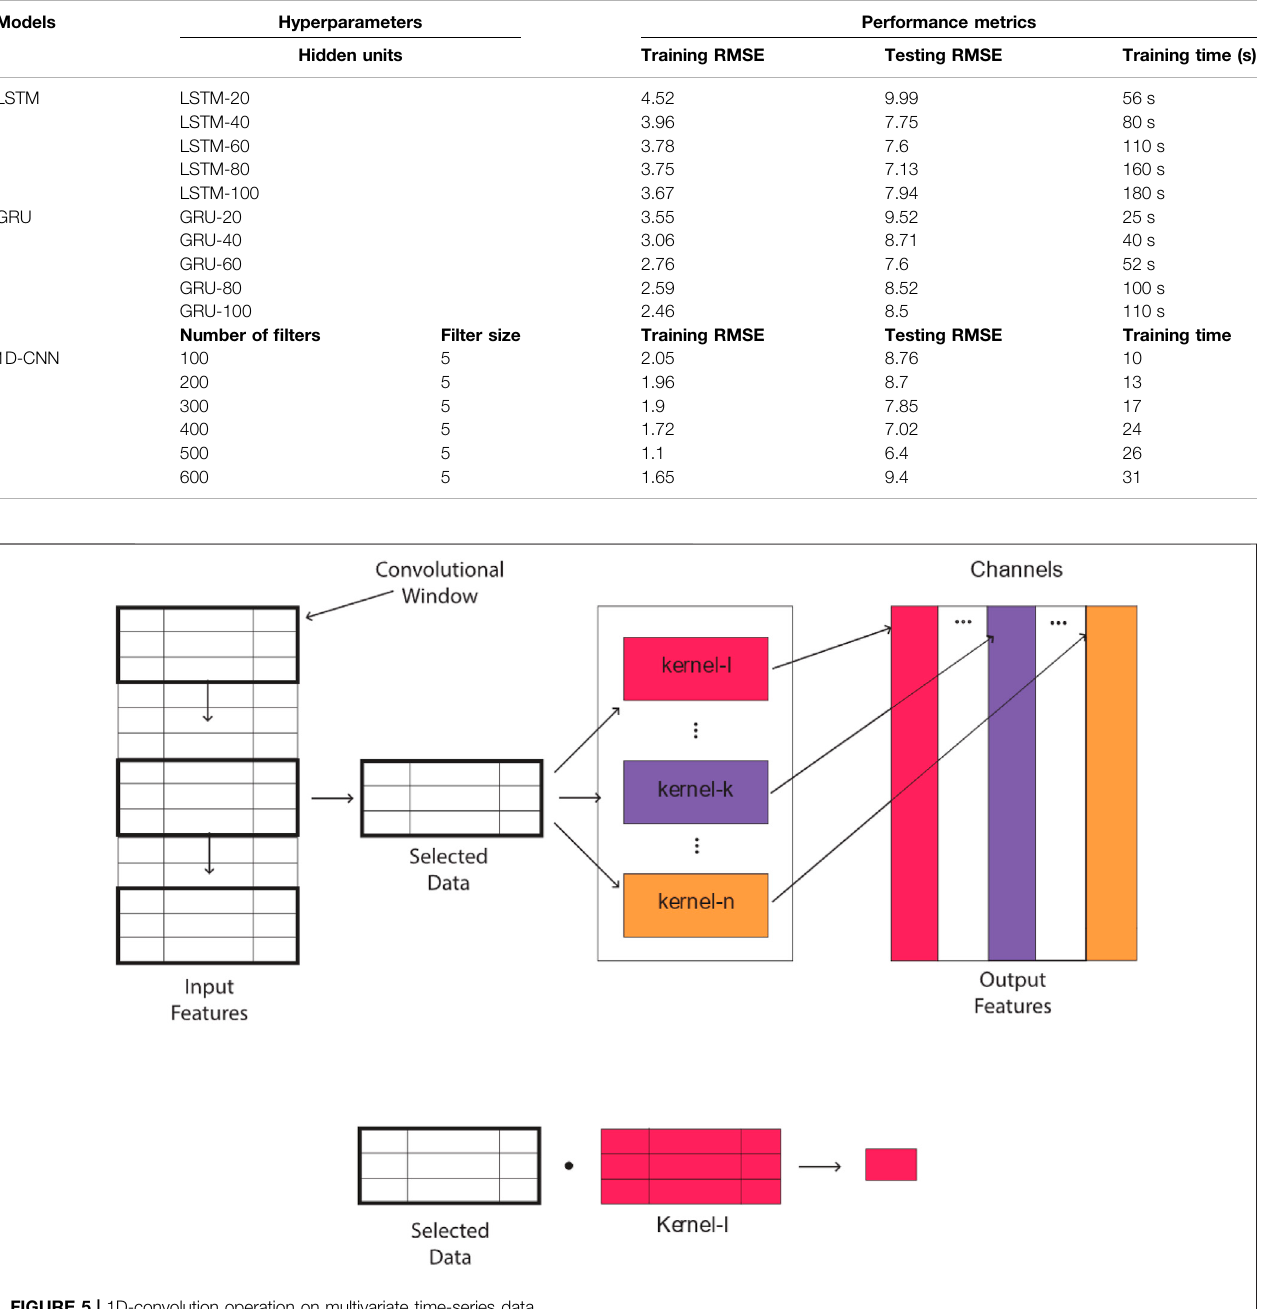
FIGURE 5 | 1D-convolution operation on multivariate time-series